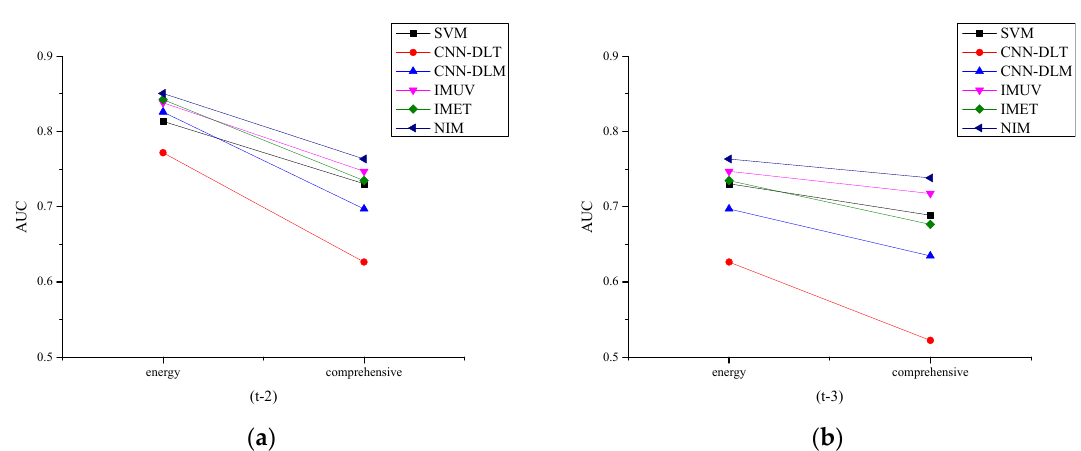
Figure 6. Performance comparisons of models with the energy training data set and the comprehensive training data set. ( a ) Evaluation results with the testing data set of the year ( t − 2 ) ; ( b ) evaluation results with the testing data set of the year ( t − 3 ) .